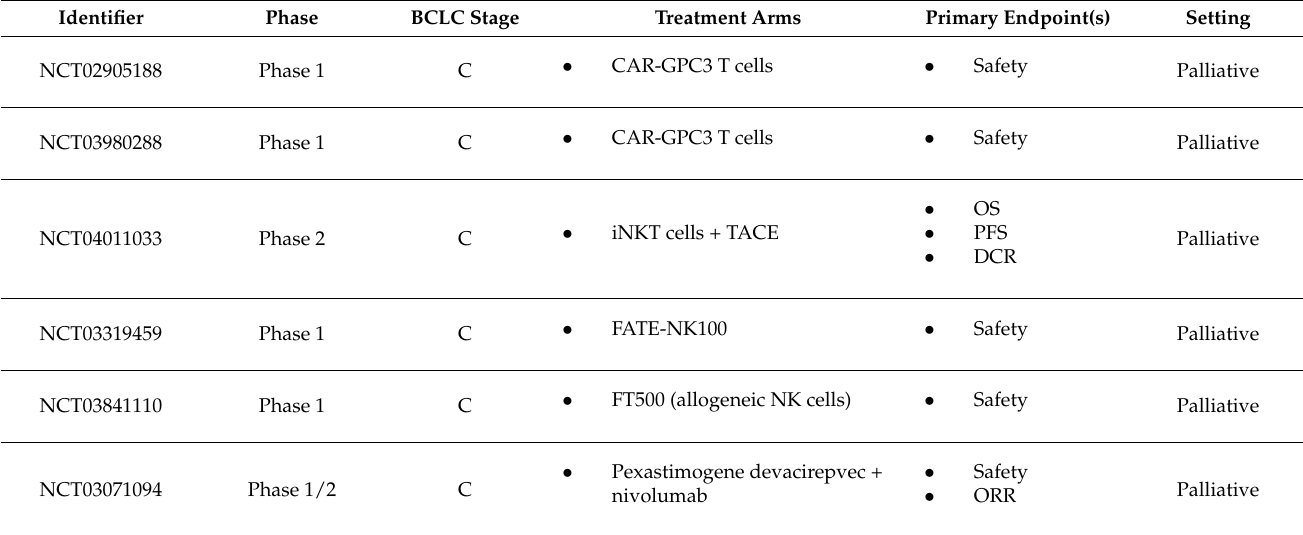
Table 6. Selection of current clinical trials on gene and cell-based systemic treatments.